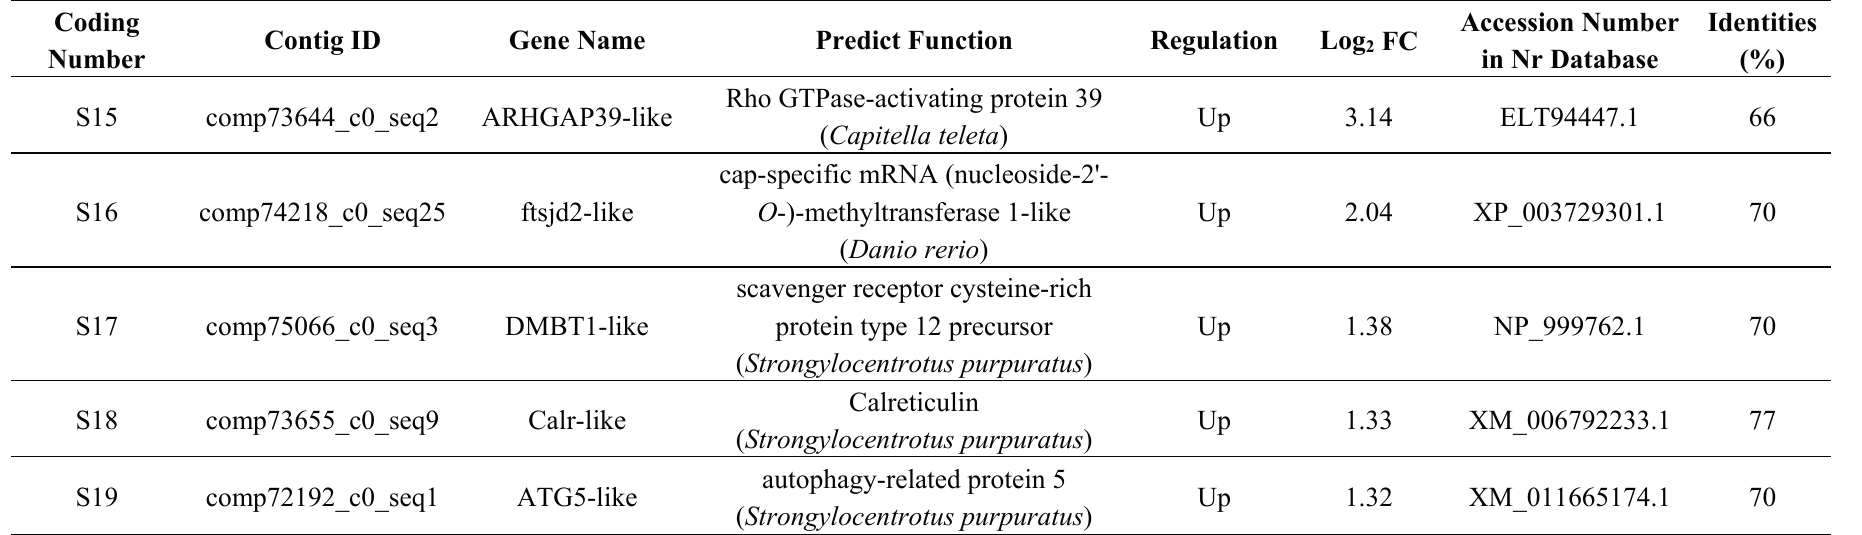
Table 6. Other putative susceptibility